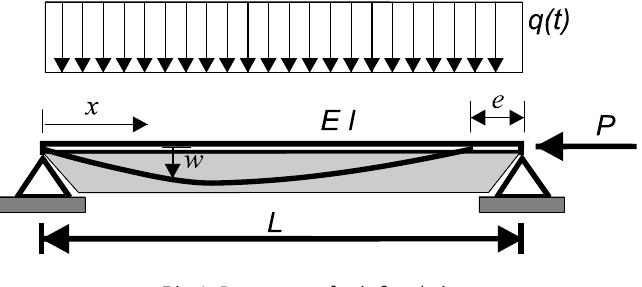
Fig. 1. Beam on an elastic